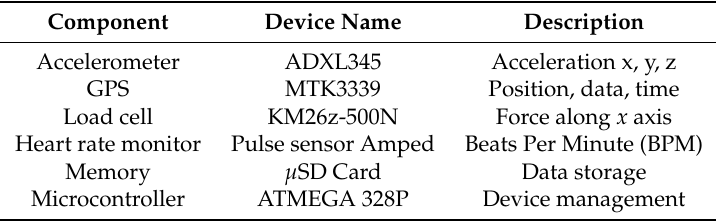
Table 1. Hardware components of the monitoring system.